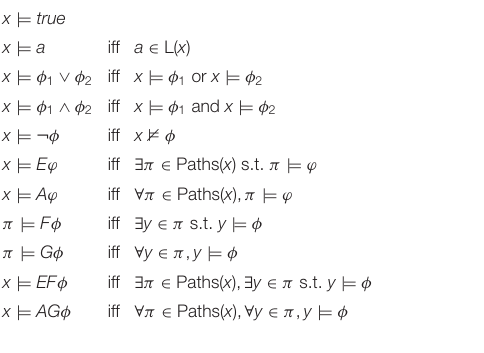
. Since (cid:127) is the (cid:127)